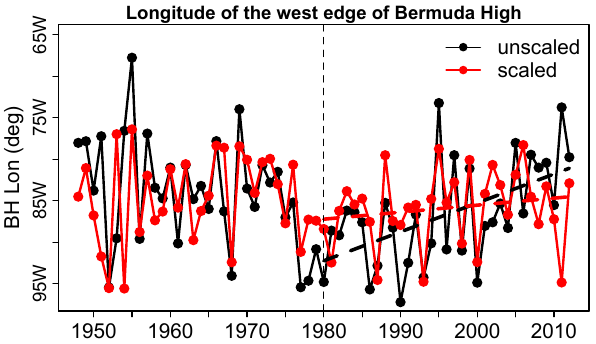
Figure 5. Time series of the longitude of the west edge of the Bermuda High (BH-Lon) in JJA from 1948 to 2012. The black curve represents the unscaled BH-Lon, as defined by the cross-point of the 1560gpm isoline and the 850hPa wind ridge line (Li et al., 2011). The red curve represents the scaled BH-Lon, in which the geopo- tential height field for each summer is scaled by the 1948–2012 av- erage height over the Bermuda High region. The dashed lines show the linear trends of BH-Lon from 1980 to 2012 for the scaled and unscaled cases. See text for further